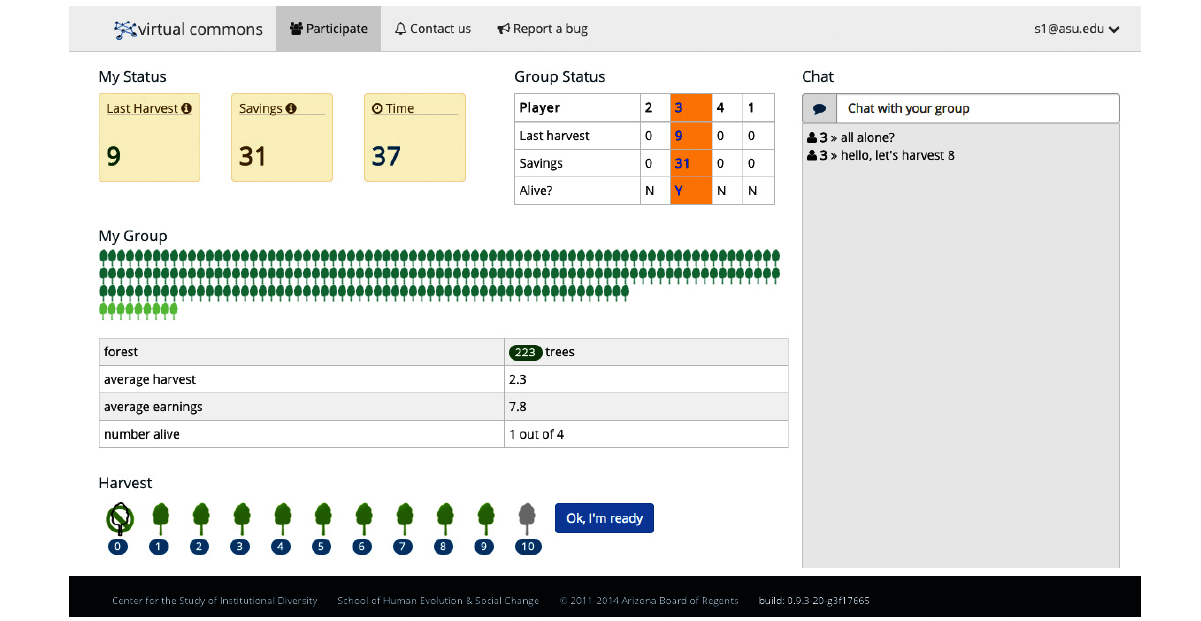
Fig. 7 . A screenshot of the VCWeb experimental environment of an experiment in which a group sees the actions of another group.